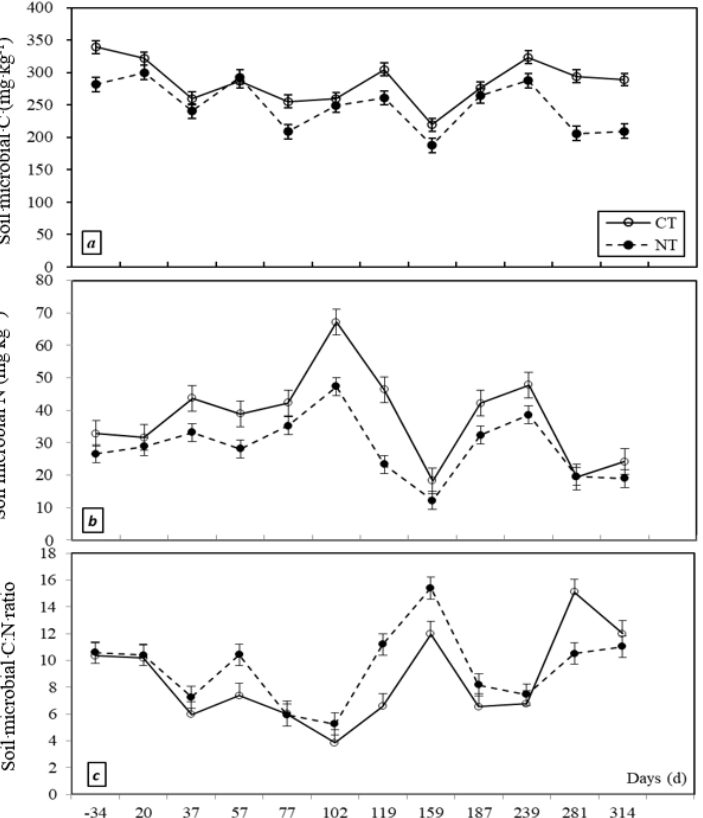
Figure 4. Variation in soil microbial C ( a ), N ( b ), and C:N ( c ) ratio under CT and NT management in a rice-oilseed rape cropping system in 2015-2016. The bars mean the standard error.